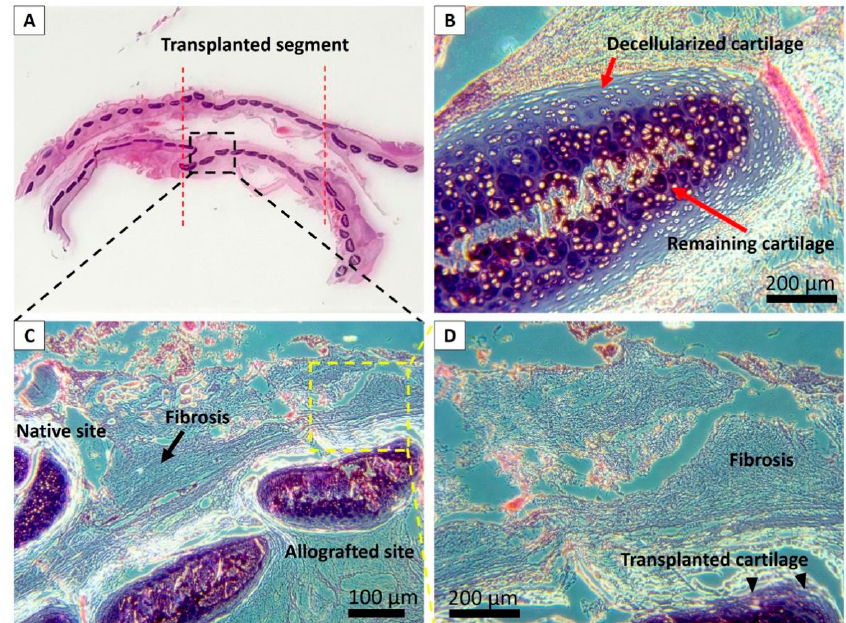
Figure 7. Histological evaluation of the tracheal allograft segment in rabbits two months posttrans- plantation. ( A ): Microscopic observation of explanted trachea; ( B ): Remained cartilage in the transplanted scaffold; ( C , D ): Fibrosis was significantly found at the luminal surface of the transplanted graft, which was accompanied by the incomplete coverage of the regenerated epithelium. Despite a long-term follow-up until two years was achieved in one rabbit, non-lethal stenosis at the middle part of the transplanted segment can still be observed. This fibrosis had a tendency to develop at the luminal aspect of the transplanted graft and protruded into the tracheal lumen, forming a circular stenosis ring, which is compatible with the endoscopic findings (Figure 8).